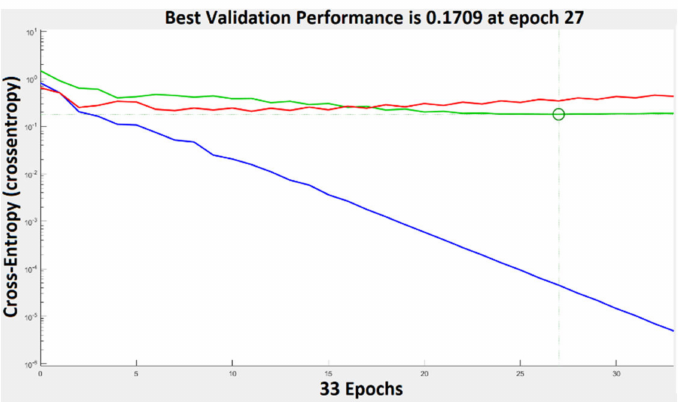
Figure 11. Training performance in case of PH 2 database. Blue represents the training, green—the validation, red—the testing, and circle—the best validation performance.